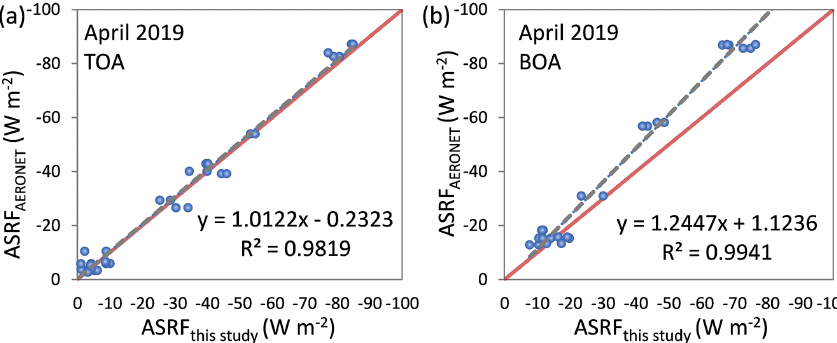
Figure 11. Correlations of instantaneous ASRF between radiative transfer (RT) model simulations in this study and the AERONET products during the DAO-K campaign: (a) TOA and (b)